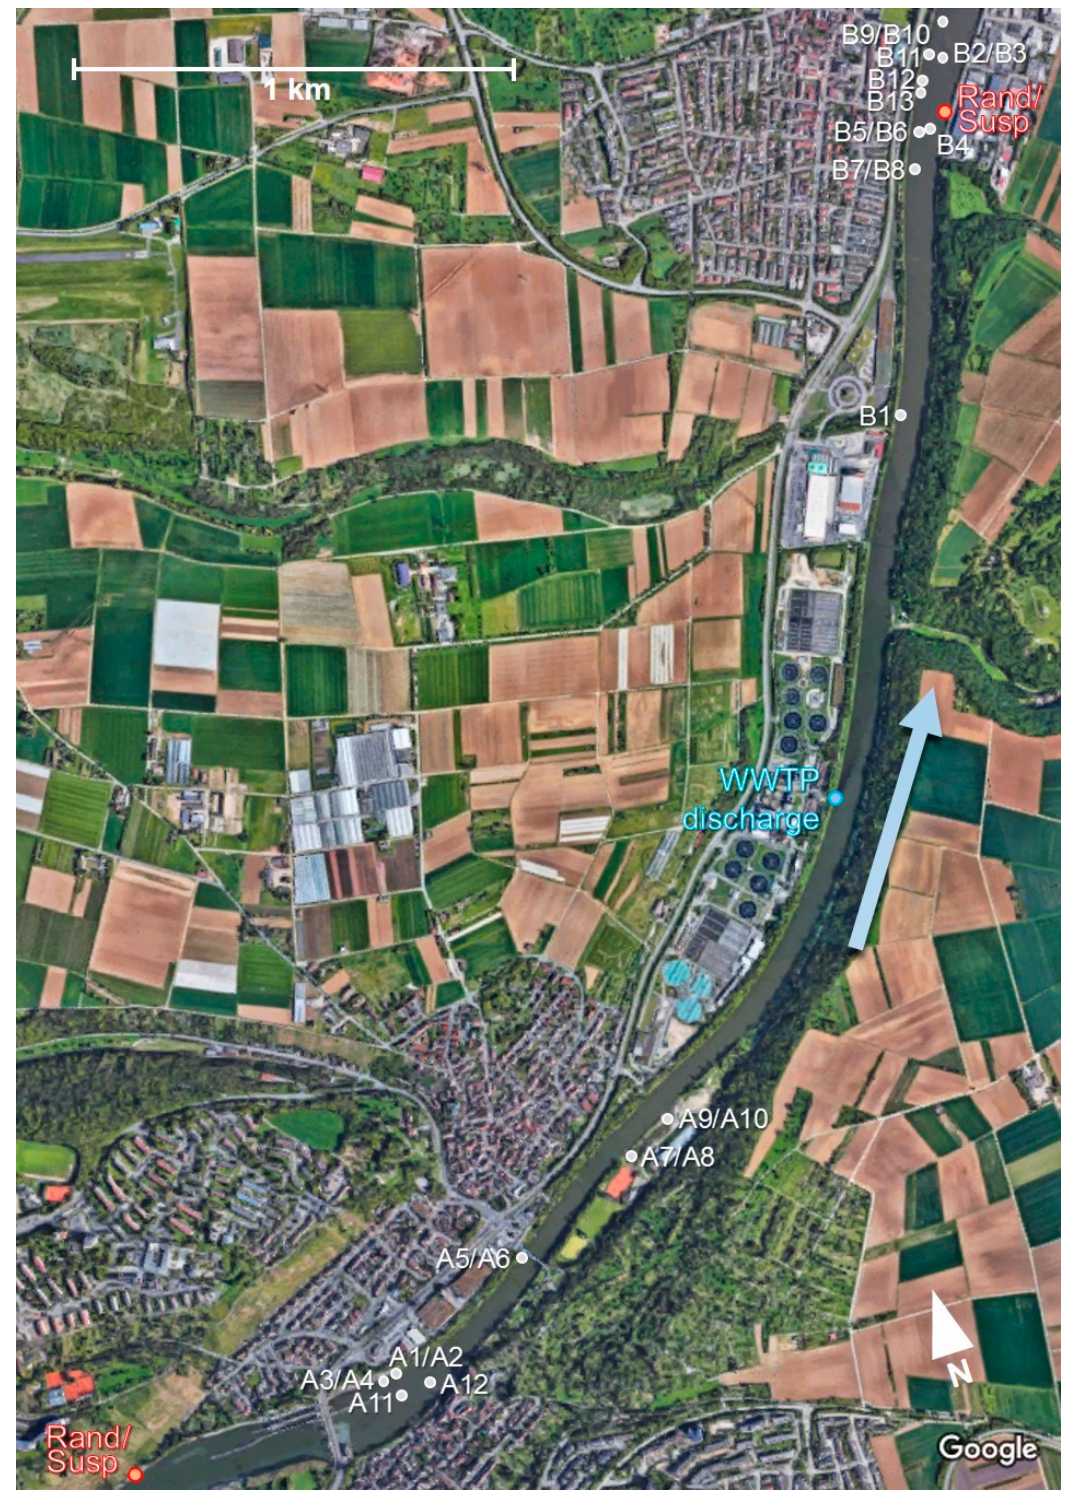
Figure A1. Sampling points of liquid random samples (Rand), suspended matter samples (Susp), and sediment samples (white points, A: before WWD and B: behind WWD) of River1 (Google Maps).